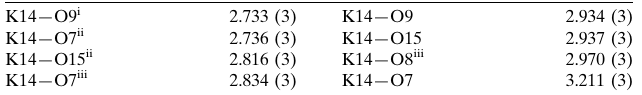
Selected bond lengths (A˚ ).